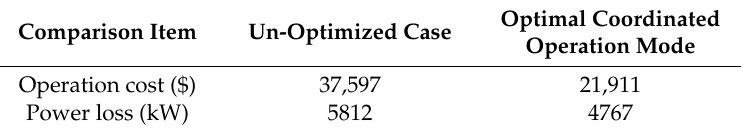
Table 2. Daily Operating Costs and Active Power Losses for the Distribution